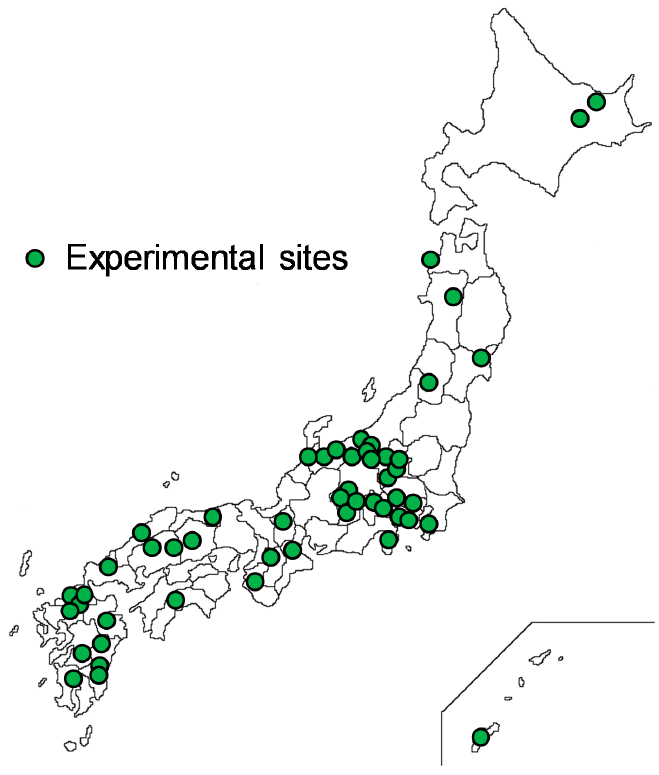
Figure 1. A map showing the distribution of all 52 locations.